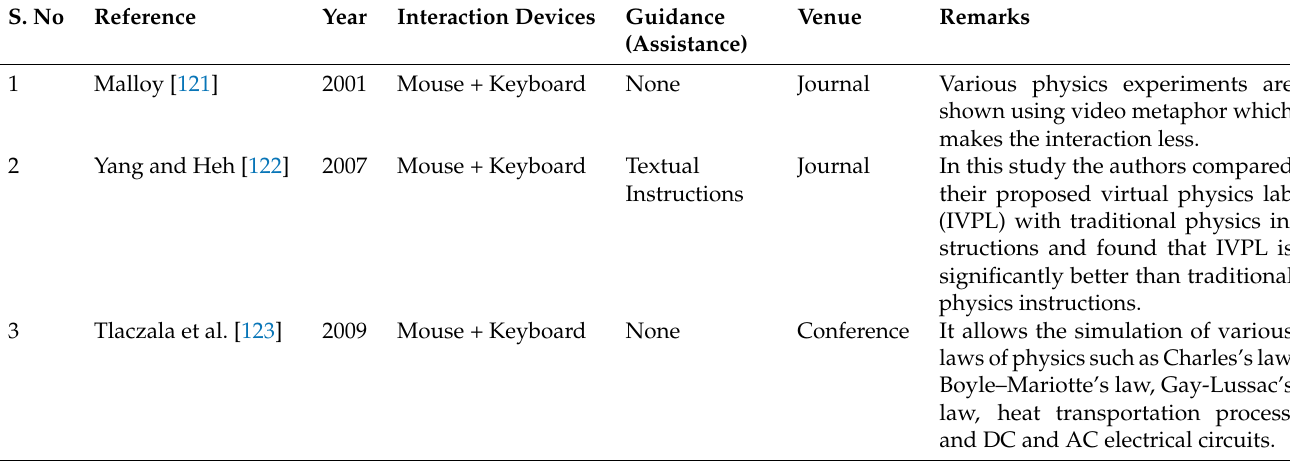
Table 5. Analysis of the existing interactive physics laboratories in